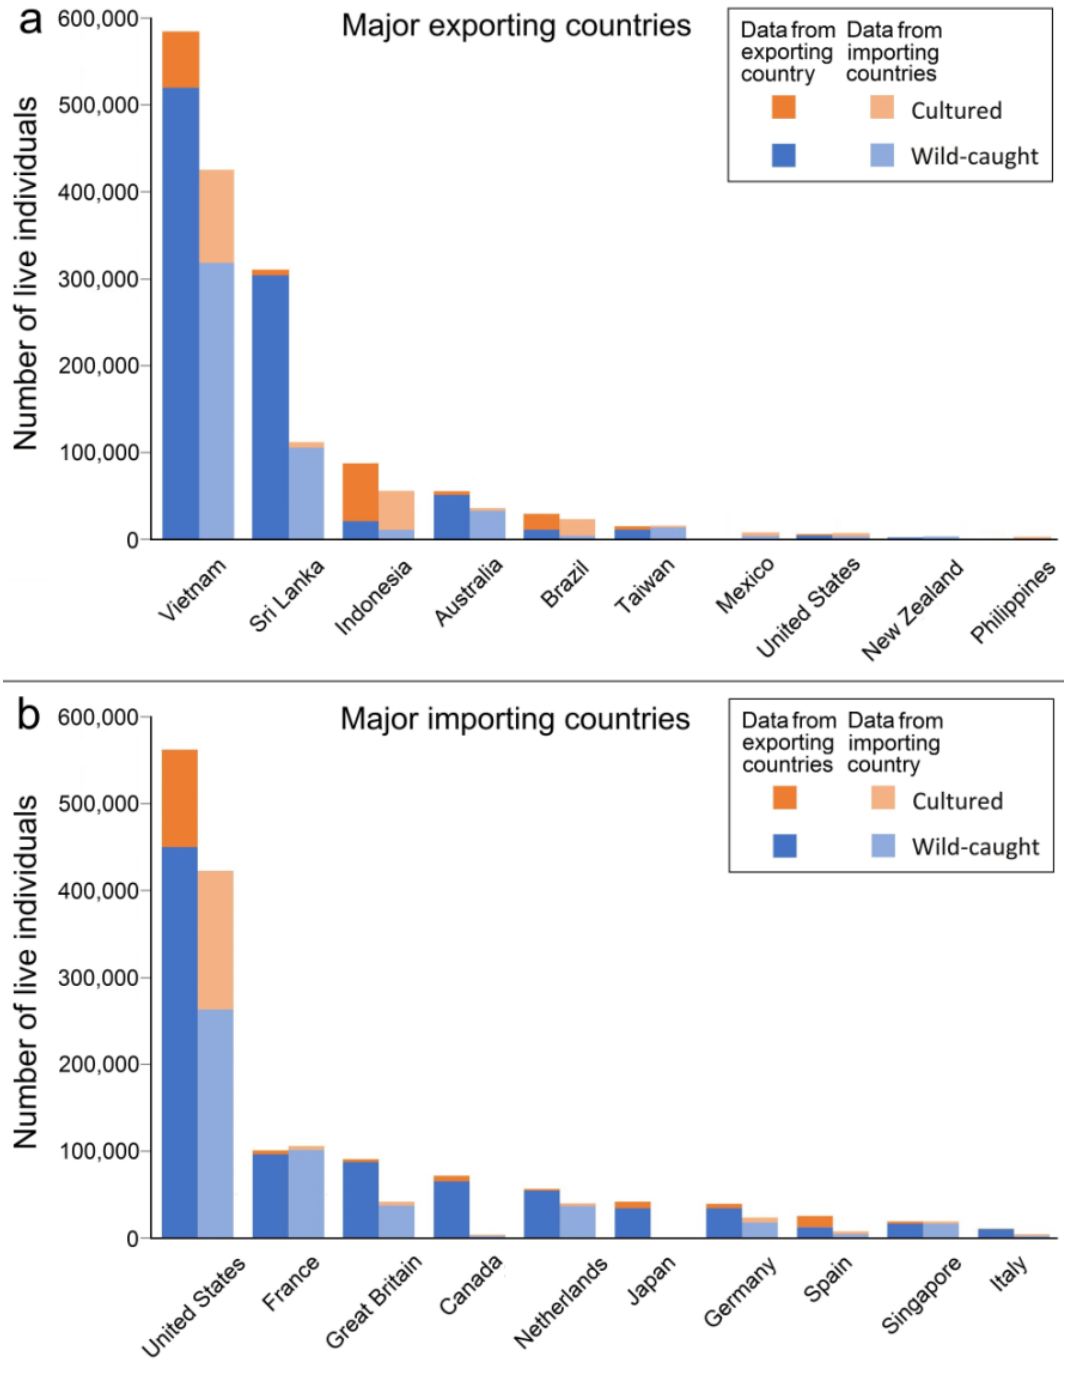
Figure 7. Trade in live Hippocampus individuals by source category, wild-caught (W + U) or cultured (C + F), for the 10 most important exporting ( a ) and importing ( b ) countries in 2004–2018 [69]. A distinction is made between data from exporting countries and importing countries.